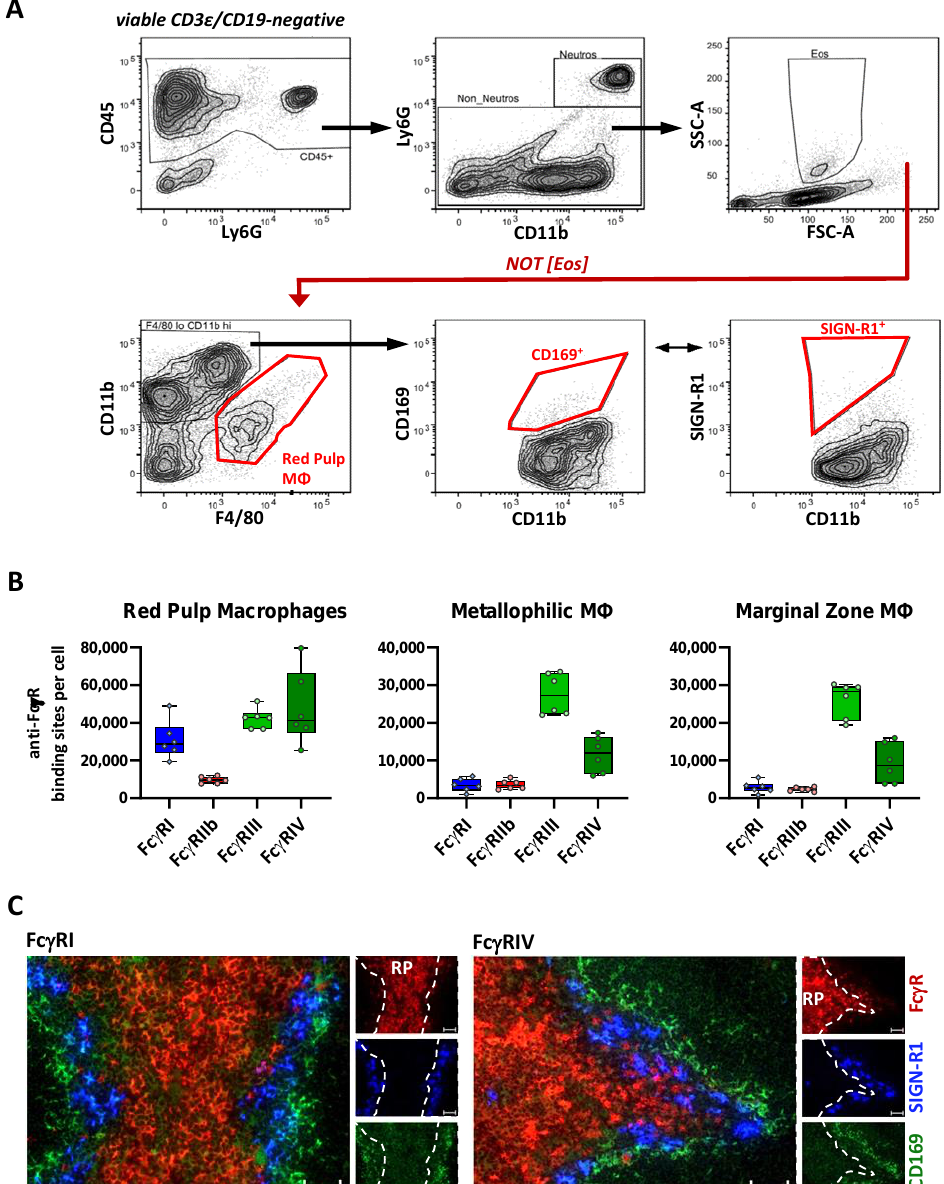
Figure 4. Characterization of the FcγR expression on splenic macrophages. ( A ) Depicted is the gating strategy for splenic macrophages. B, T and dead cells were excluded by using a dump channel (using CD19 and CD3e and DAPI). From CD45-positive leukocytes, neutrophils were excluded by Ly6G expression and eosinophils by their light scatter characteristics with high side scatter (SSC). Within the remaining leukocyte population, red pulp macrophages were characterized by low CD11b expression and pronounced F4/80 expression. Among CD11b-high cells with no or low F4/80 staining, metallophilic macrophages were characterized by the expression of CD169. Cells with a high expression of SIGN-R1 were regarded as marginal zone macrophages. ( B ) Shown are the number of anti-FcγR-binding sites per cell as a quantitative correlate of the FcγR expression on RPM, the marginal zone and metallophilic MΦ. Data are presented as box plots showing the median and interquartile range and whiskers presenting extremes with all single values. n = 6. ( C ) Analysis of the FcγRI and RIV expression on splenic macrophages by fluorescence microscopy. FcγRI (left panel) and FcγRIV (right panel) are shown in red. The presence of SIGN-R1 and CD169 is indicated by blue or green, respectively. Shown is the overlay of FcγR, SIGN-RI and CD169, as well as each single fluorescence channel. In the single-channel pictures, the position of the red pulp is shown based on its demarcation from the SIGN-R1-positive macrophages (dashed line). Scale bars represent 50 µm.